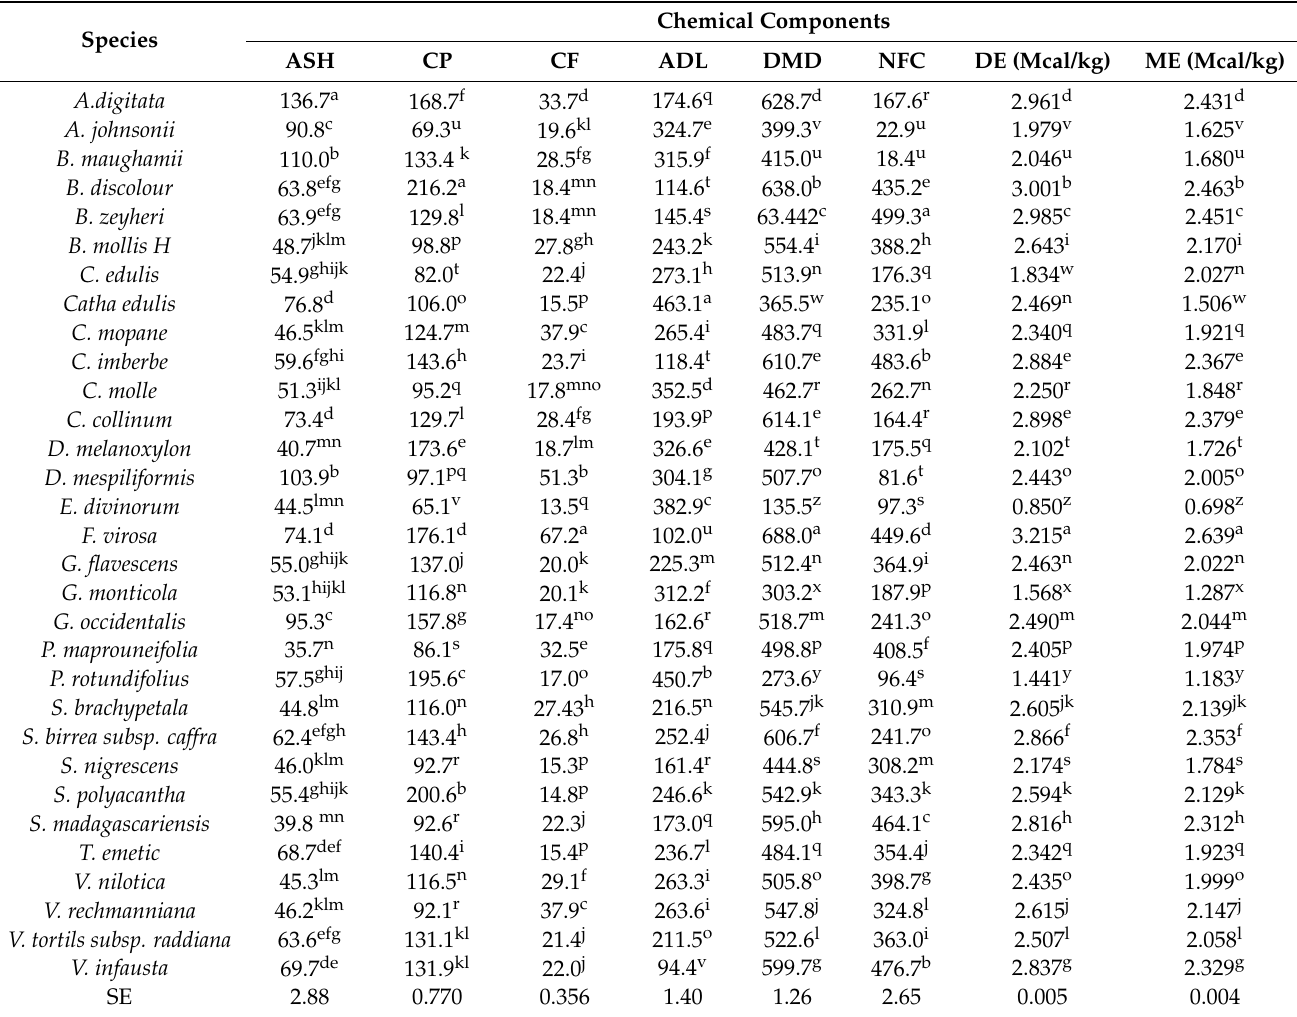
Table 1. Chemical composition (g/kg DM, unless otherwise stated) of browse species found in GM-L soil type.